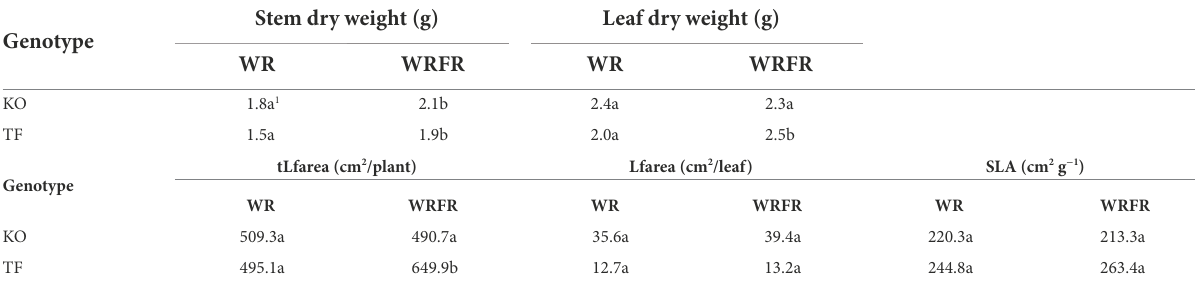
LLA, length of the long axes; LLA1, length of the order 1 long axis; LLA2, length of the order 2 long axes; NbA, number of axes; NbA2, number of order 2 axes; NbA3, number of order 3 axes; NbA2_bas, number of order 2 axes carried by the order 1 long axis in basal position; NbA2_med, number of order 2 axes carried by the order 1 long axis in median position; NbA2_ top, number of order 2 axes carried by the order 1 long axis in apical position. NbDetA, number of determined axes; NbDetA2, number of determined order 2 axes. 1 Means followed by the same lowercase letter in the same line are not significantly different (Tukey’s test, p < 0.05). TABLE 4 Least-square means (LS means) of stem and leaf morphological variables measured at the ‘VFB of the order 2 axes carried by the order 1 long axis in apical position’ stage for Knock Out ® Radrazz (KO) and ‘The Fairy’ (TF) grown in a climate chamber under two light conditions: WR and